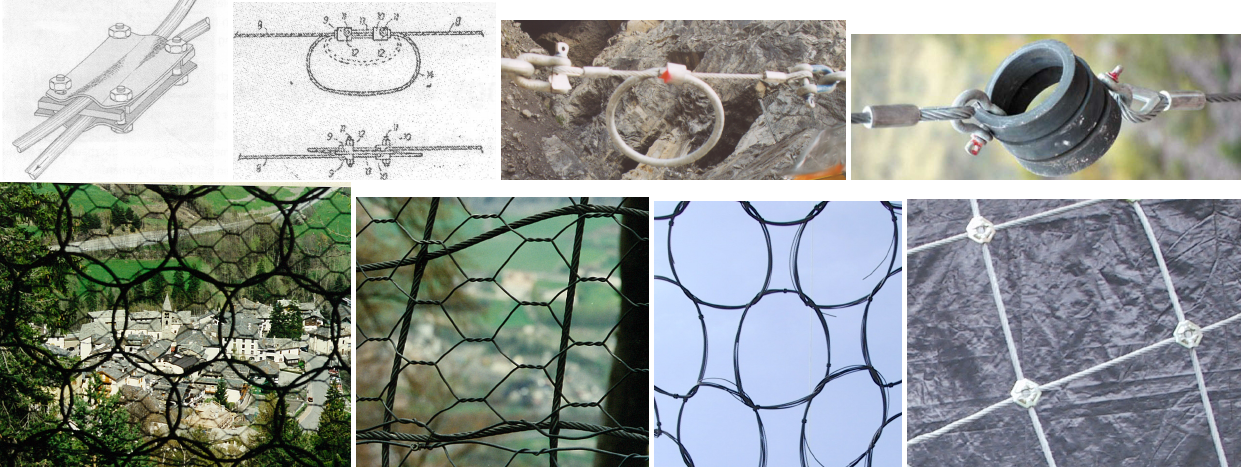
Fig. 18. Different types of energy absorbing barrier components (friction of tensioned rope between friction plates, friction between rope clamps, bent steel pipe circle narrowing under tension, and elongating spiral structures) and mesh types (originally anti-submarine net, hexagon mesh and spliced rope net, ring net, rope net with clamps).